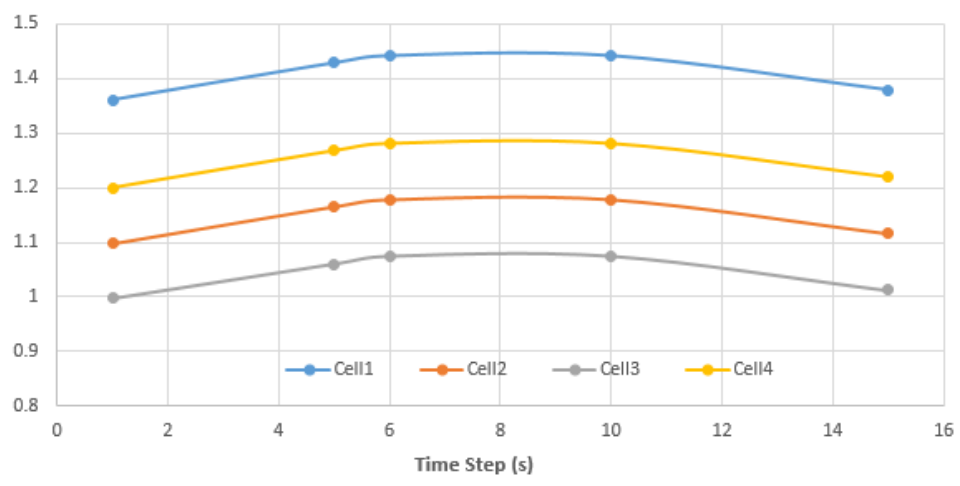
Figure 4. The relation between time step and flood depth at four indicated cells (Cells 1 – 4) in the floodplain.